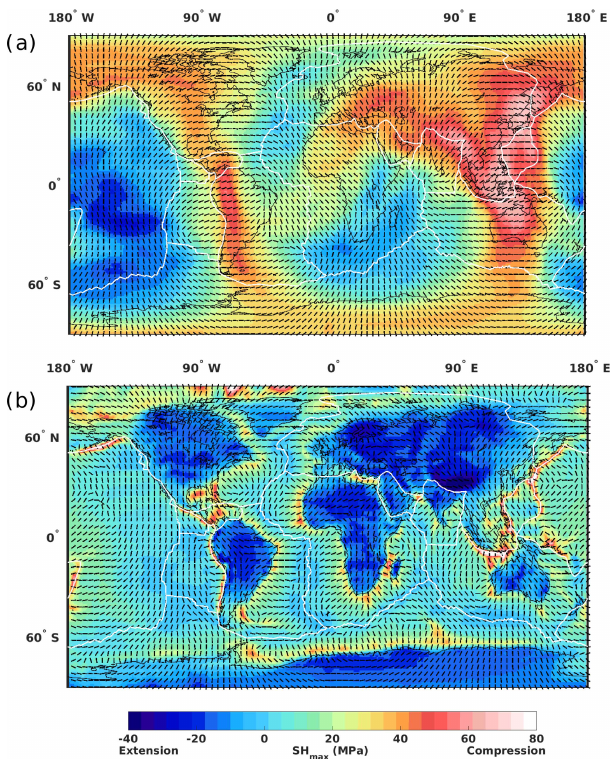
Figure 3. (a) Model-based maximum horizontal stress magnitude and most compressive stress directions [SH max ] following the con- vention with compression being positive, originating from man- tle flow driven by density anomalies below 300km. (b) Same for structure of the top 300km of the upper mantle, computed with the CRUST 1.0 model and TM1 beneath air (free